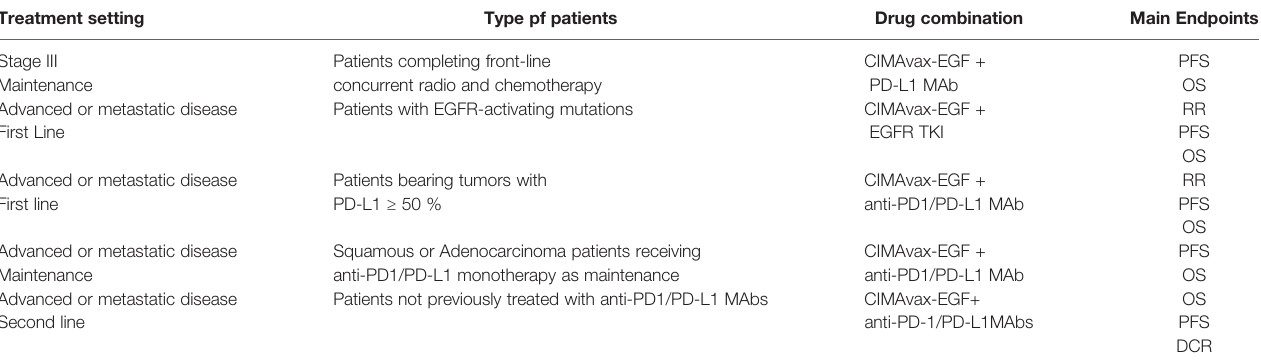
TABLE 3 | Potential combination trials of CIMAvax-EGF plus EGFR TKIs or ICIs. Treatment